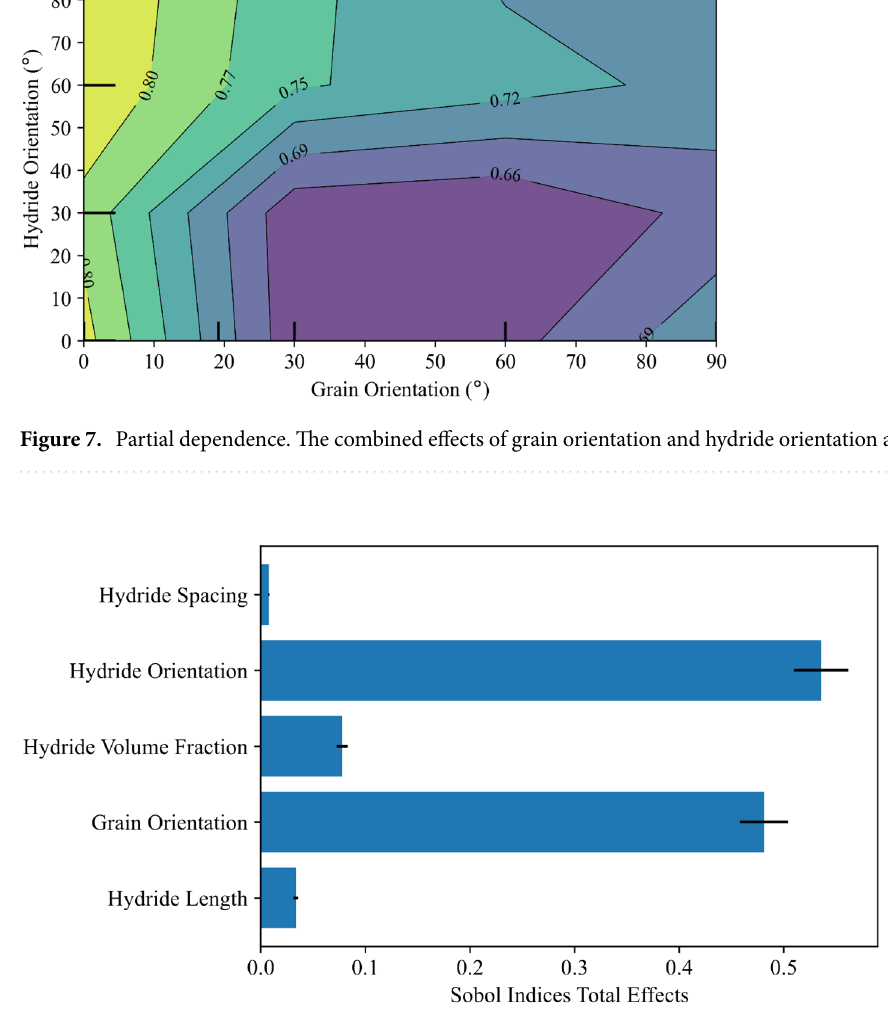
Figure 8. Sobol analysis for material fingerprint showing total effects . Calculated for the 3.25% nominal strain MLP model. 95% confidence intervals are indicated by black